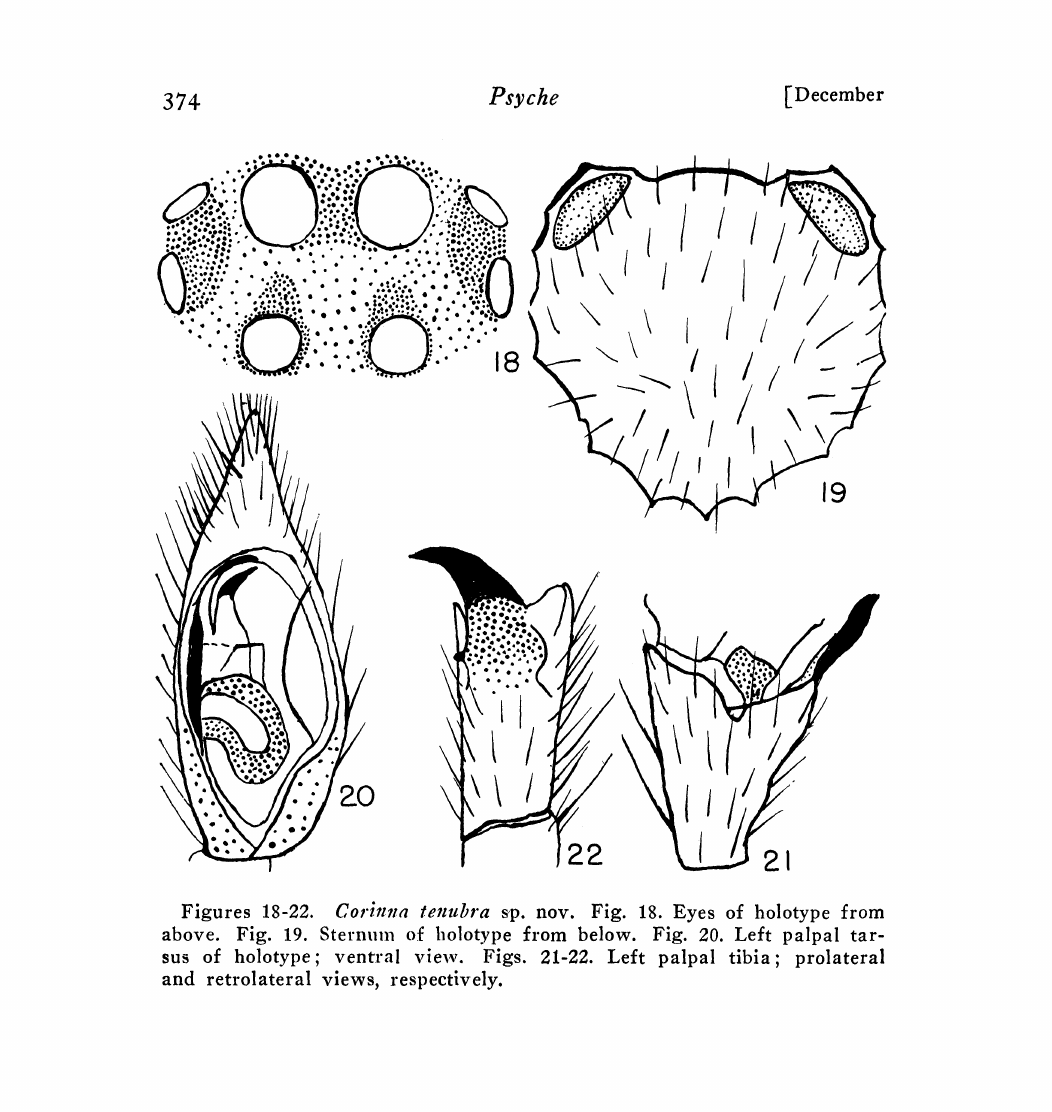
Figures 18-22. Corinna lenubra sp. nov. Fig. 18. Eyes of holotype from above. Fig. 19. Sternum of holotype from below. Fig. 20. Left palpal tar- sus of holotype; ventral view. Figs. 21-22. Left palpal tibia; prolateral and retrolateral views,